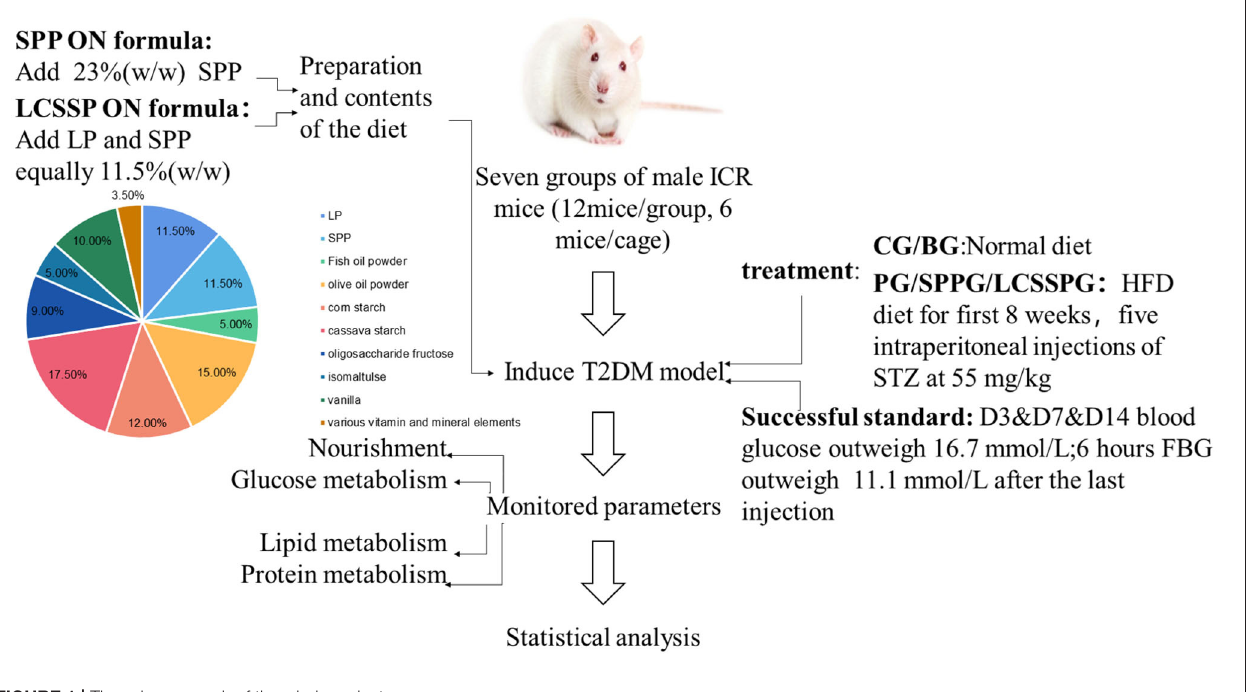
FIGURE 1 | The scheme graph of the whole project.